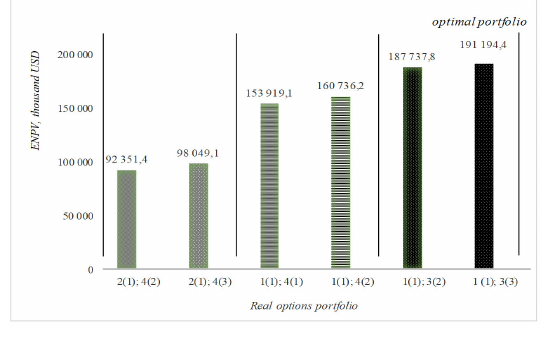
portfolio definition: Fig. 7. Comparison of ENPV for selected real options